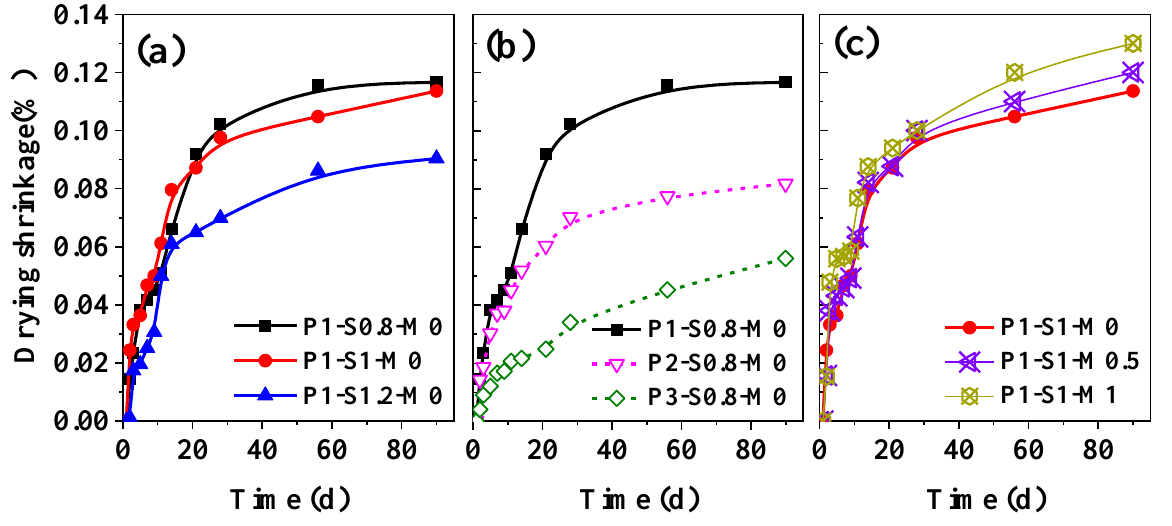
Figure 10. Drying shrinkage of samples with time. ( a ) effect of s/b ratio, ( b ) effect of FA/GGBS mass ratio, ( c ) effect of silicate modulus.